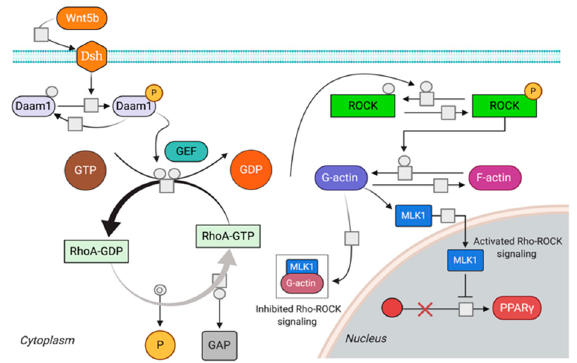
Figure 11. Scheme of reactions proposed for Rho pathway modelling. MLK1 shuttles between the cytoplasm and the nucleus where it transduces signals from the cytoskeleton and inhibits the expression of PPAR γ when the RhoA-ROCK path- way is active. Reduction in RhoA-ROCK activity induces cytosolic accumulation of G-actin (globular). G-actin dimerizes with MKL1 preventing its migration to the nucleus, result- ing in the repression of myogenic genes and activation of PPAR γ